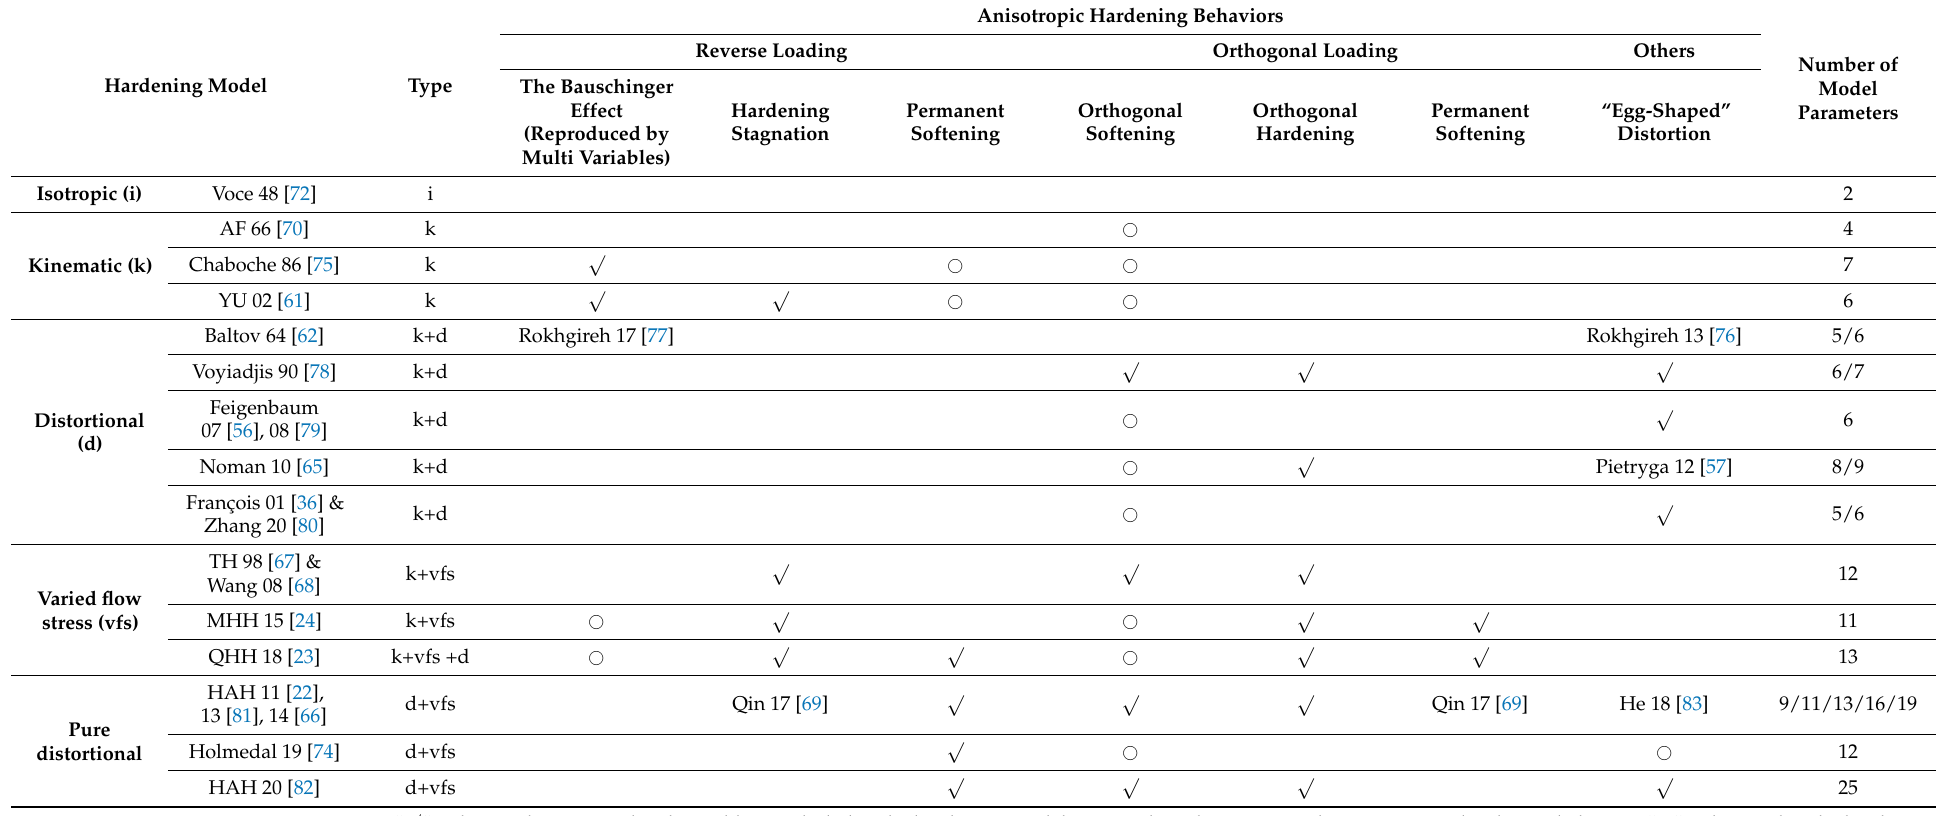
Table 2. Capability of different models to describe each anisotropic hardening